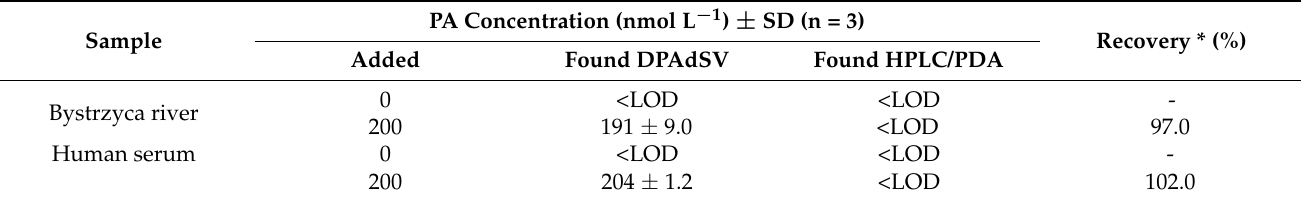
Table 3. The results of simultaneous PA, DF, and TR determination in river water and human serum samples.